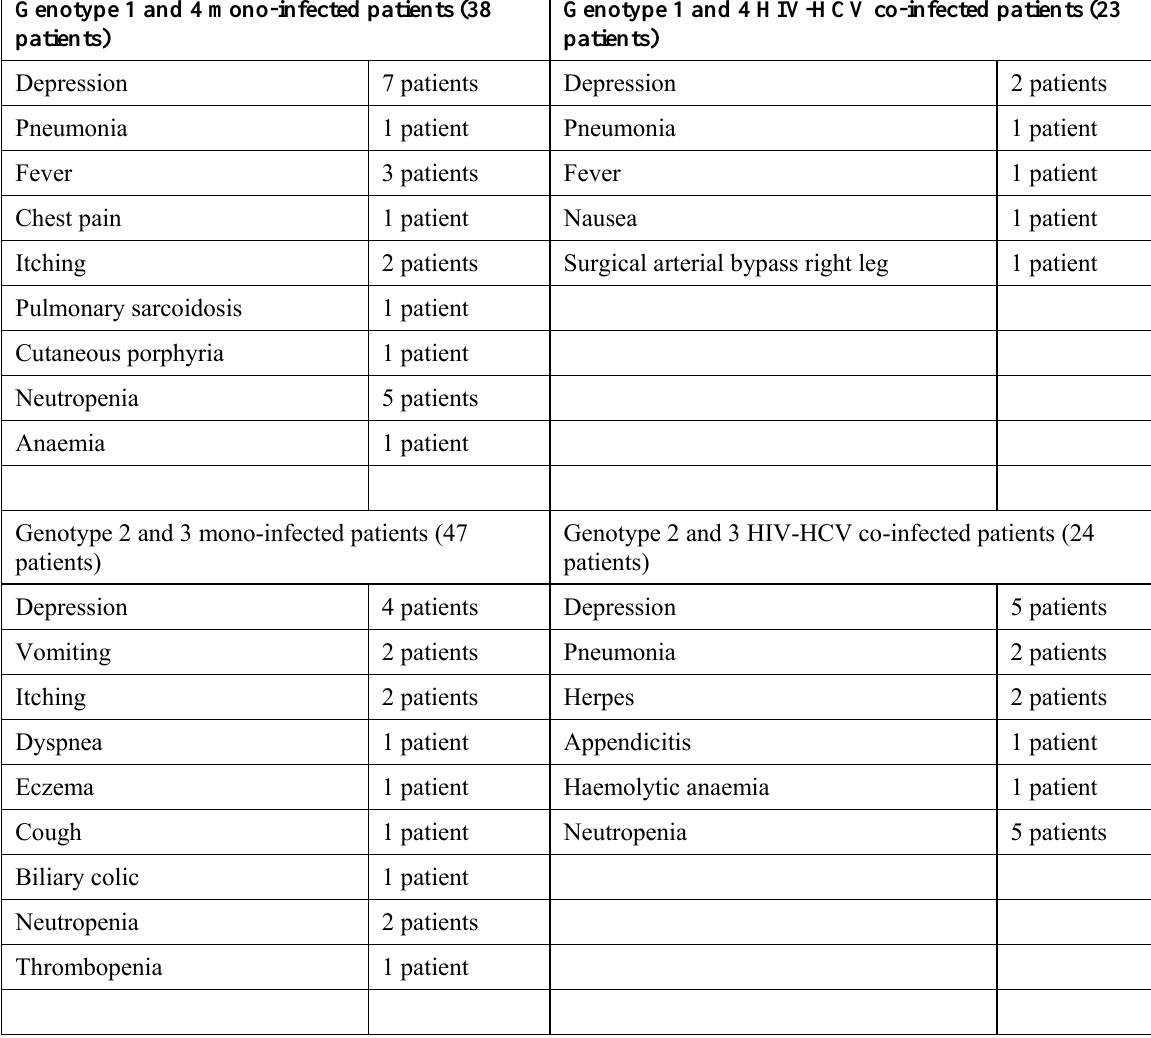
Adverse events observed during treatment without leading to treatment stop. Genotype 1 and 4 mono-infected patients